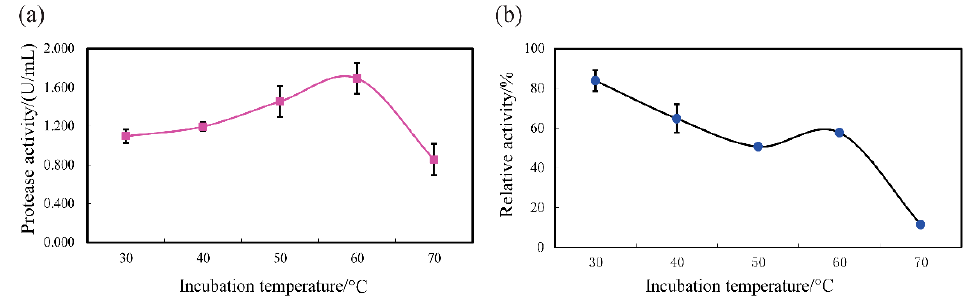
Figure 5. Thermal profile ( a ) and thermal stability ( b ) of SVCE3(f) from squid viscera. Thermal profile was measured with casein as substrate at pH 3.0.